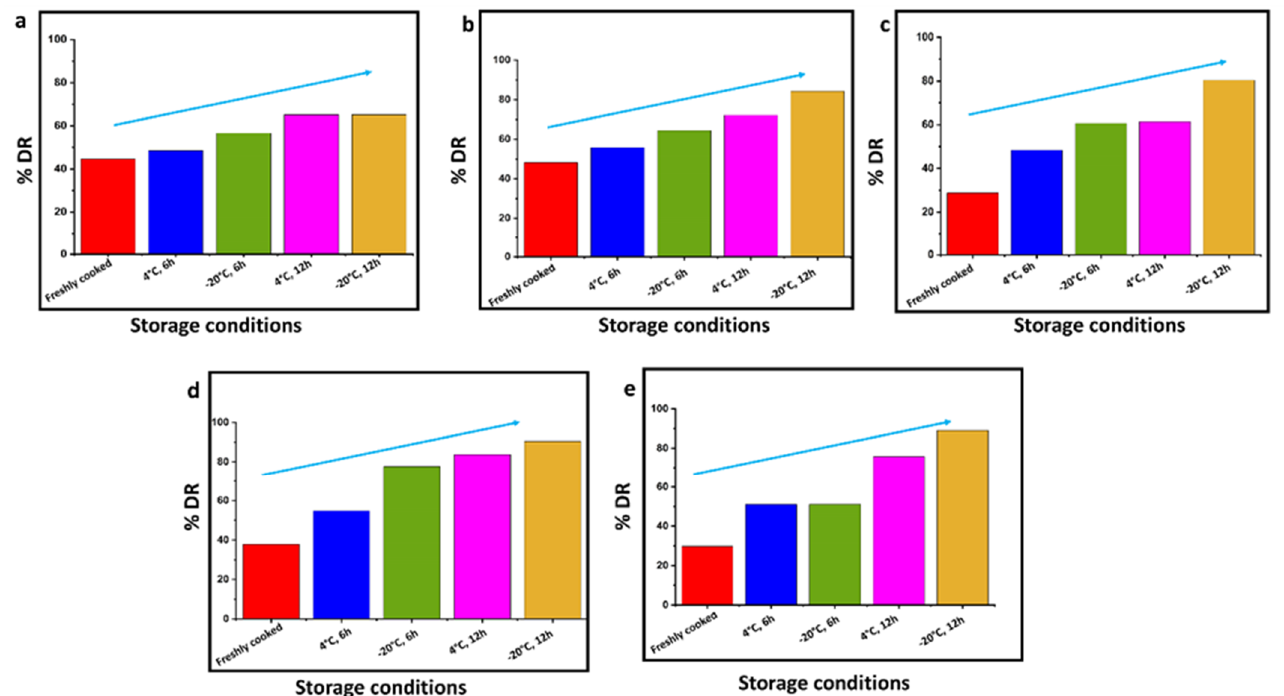
Figure 2. Degree of retrogradation (%DR) increases with increasing time and decreasing tempera- ture of storage: ( a ) Diasang lahi, ( b ) Khaju lahi, ( c ) Dhusuri bao, ( d ) Omkar, and ( e ) Bili rajamudi .